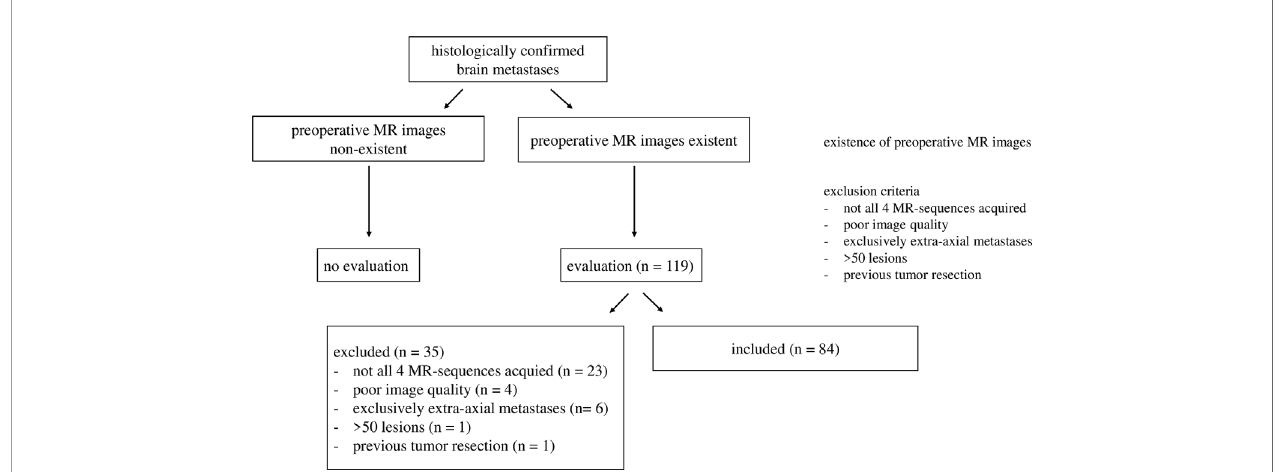
FIGURE 1 | Inclusion of patients with brain metastases. The fi nal number of included patients is n =